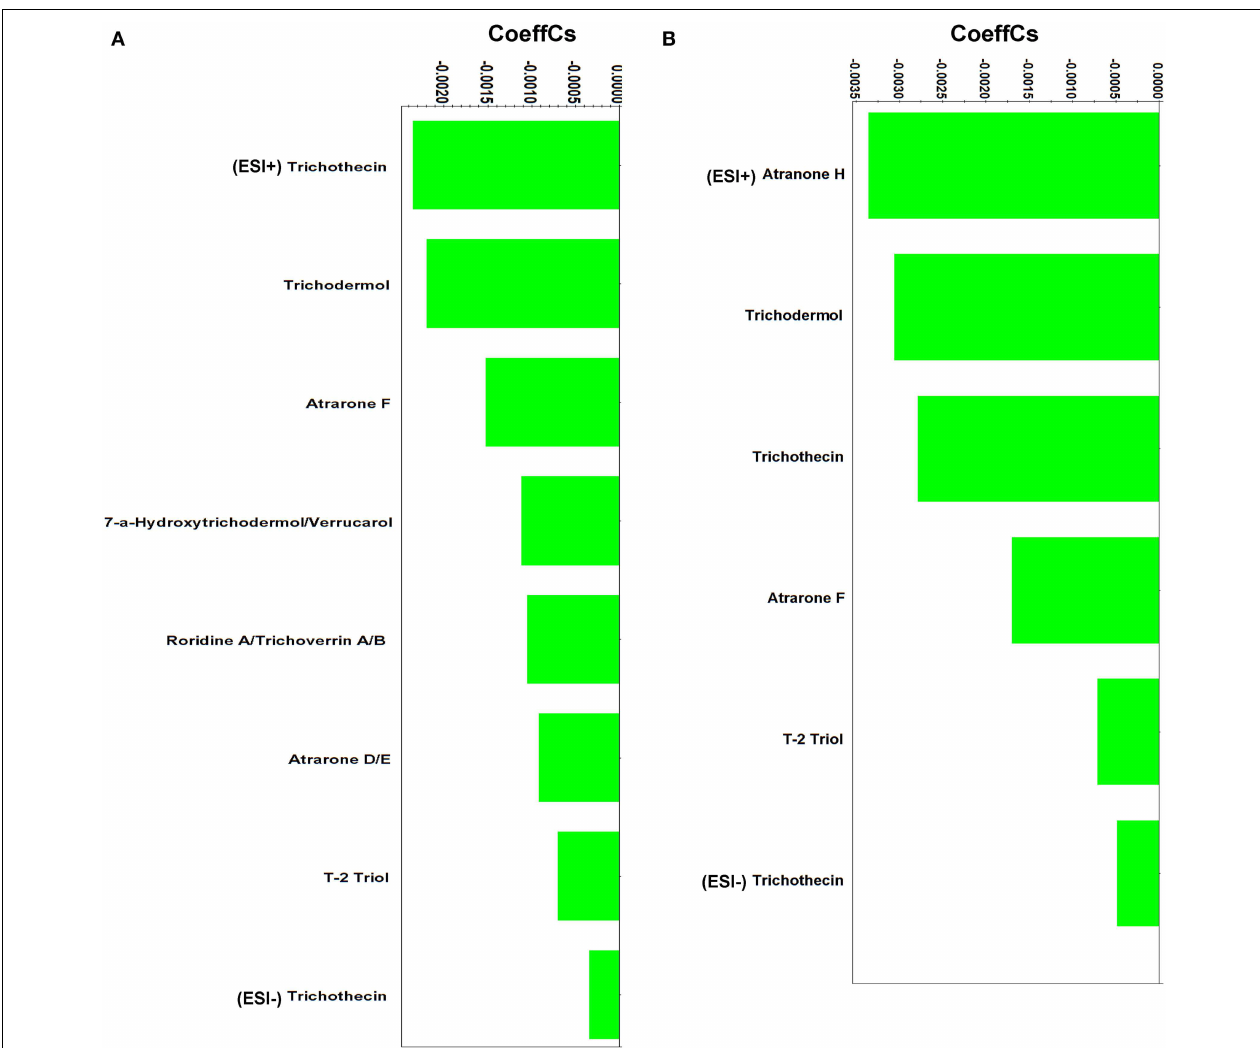
FIGURE 6 | Partial least squares (PLS) coefficient plots for Stachybotrys elegans -derived metabolites that were identified during mycoparasitism with values of scaled and centered PLS regression coefficients (CoeffCS) (ESI + ; positive electrospray mode, ESI − ; negative electrospray mode).